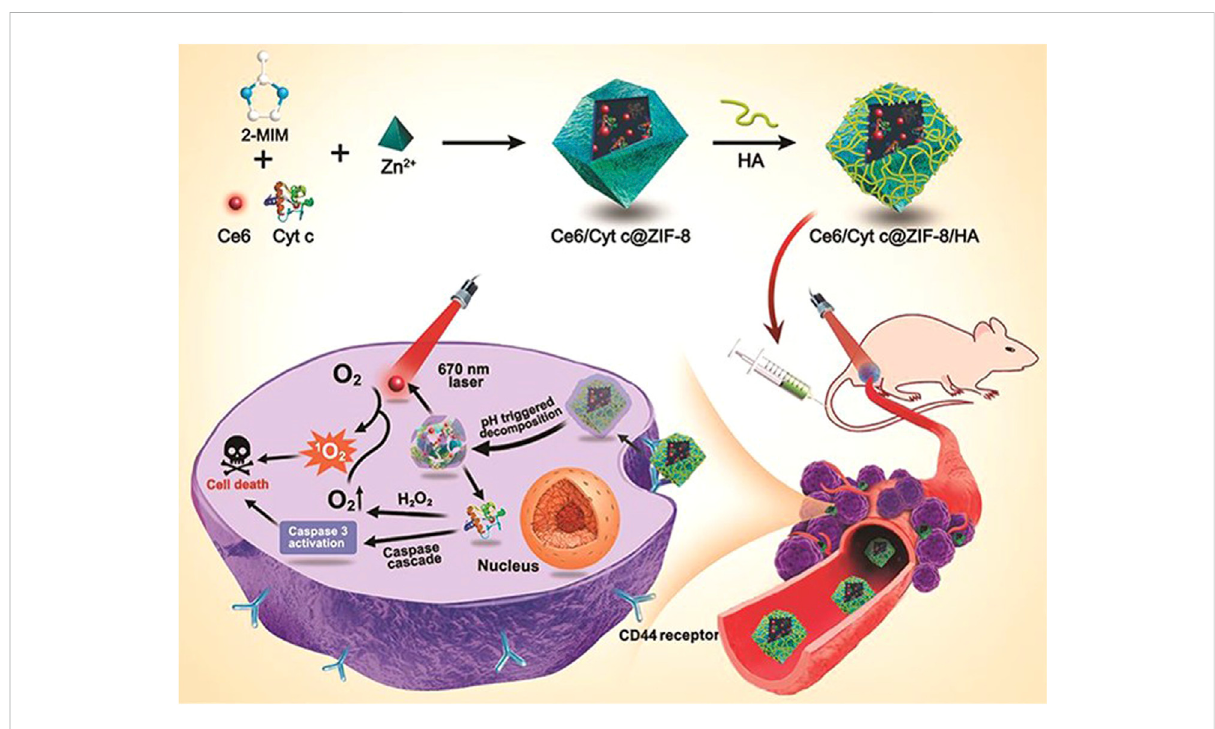
FIGURE 9 Illustration for the Synthesis of Ce6/Cyt c@ZIF-8/HA NPs and Their Applications in Cancer Cells Targeted Photodynamic and Protein Synergy Therapy. Reproduced with permission from Ref. (Ding et al., 2020).